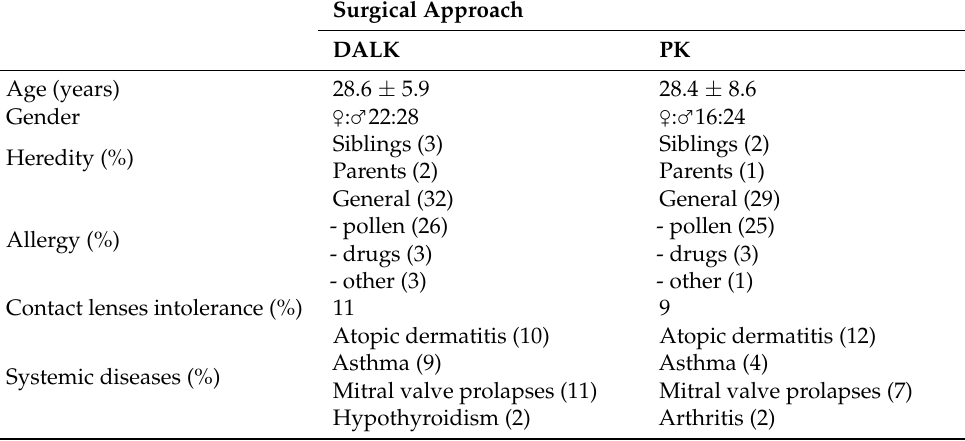
Table 2. Patient